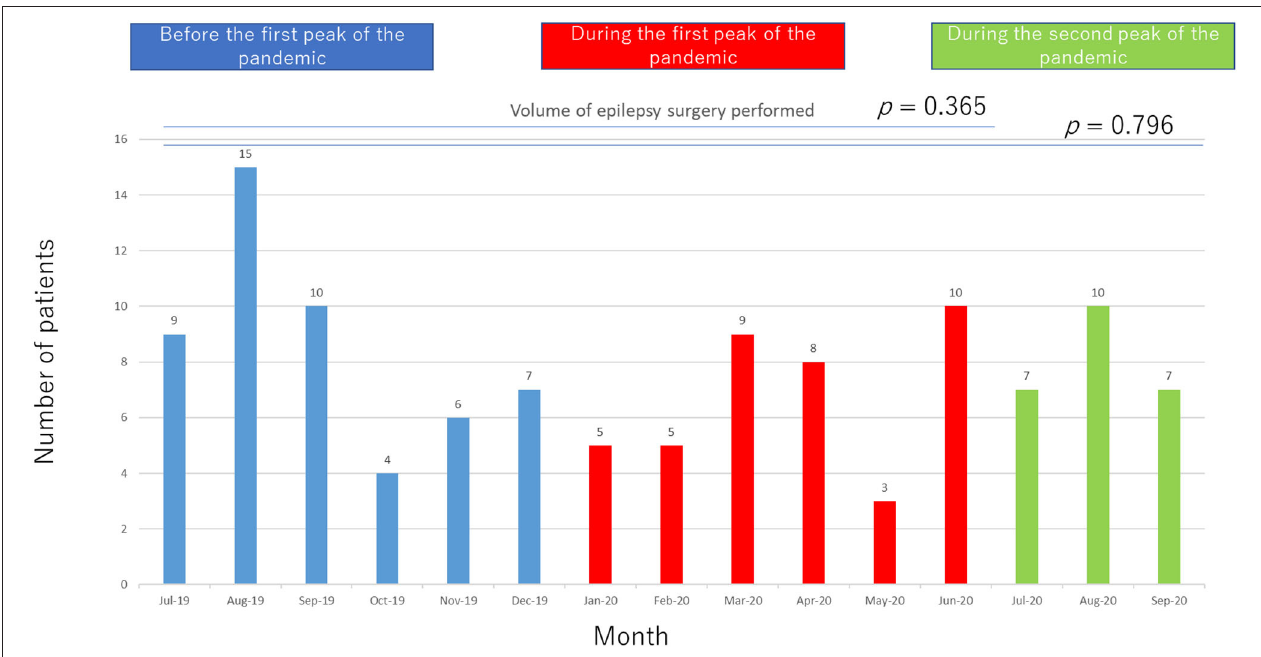
FIGURE 4 | Monthly volumes of epilepsy surgeries performed.